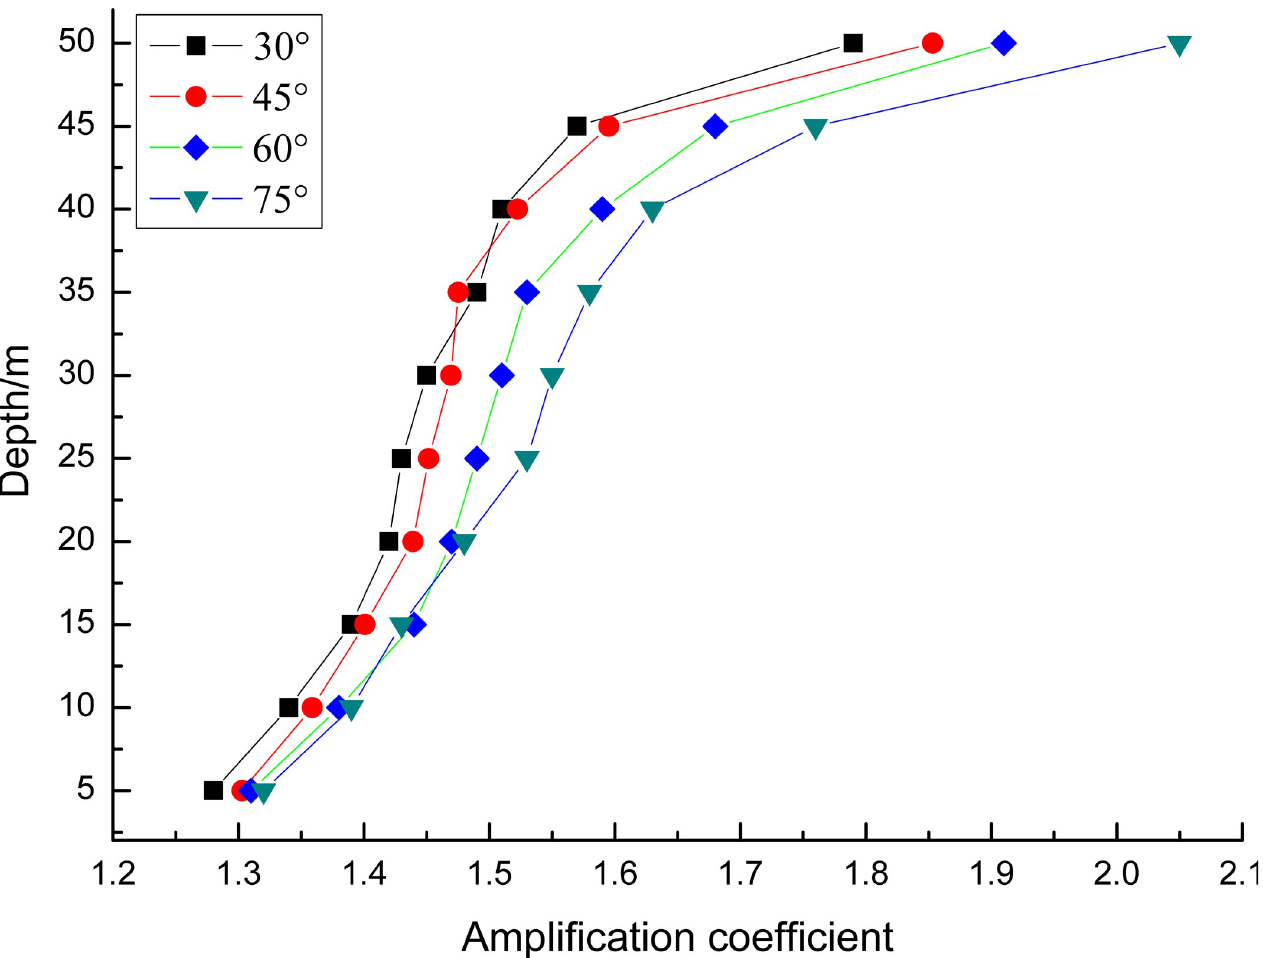
Fig 13. The impact of slope angle on the amplification coefficient of peak ground acceleration.